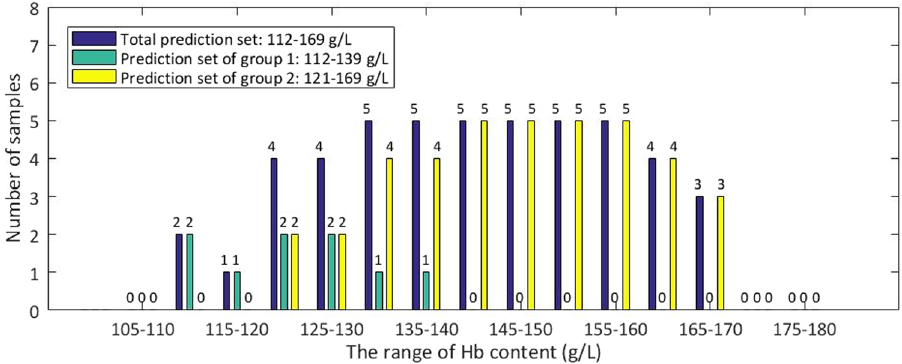
Figure 9. Distribution of Hb content of the Total prediction set, the prediction set of group 1 and group 2.